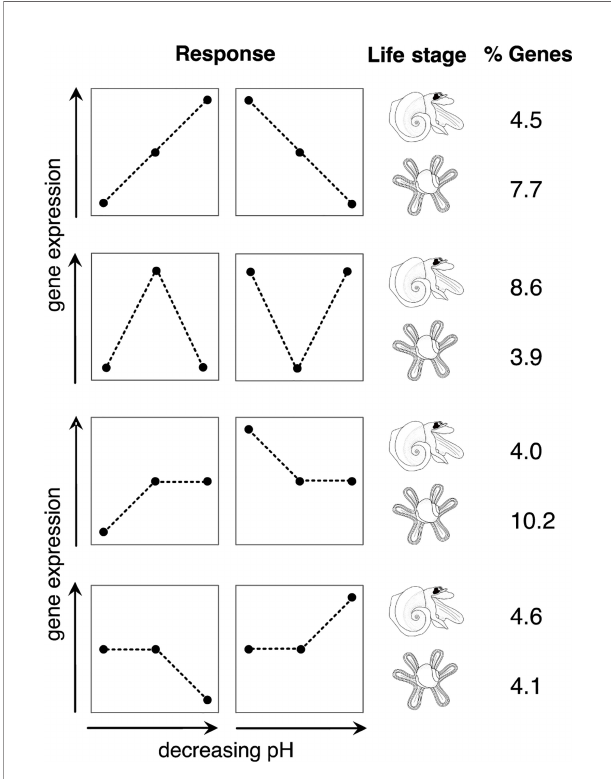
FIGURE 4 | Percentage of genes in adult and juvenile Atlanta ariejansseni following the four main gene expression patterns in response to past, present and future ocean chemistry conditions. Four responses (from top to bottom): gene expression patterns correlated with a decrease in pH (linear response), gene expression patterns in accordance to change of the ambient condition ( ‘ U- shaped ’ response), differential expression patterns only in the past condition and differential expression patterns only in the future condition. The horizontal axis of the response plots represents the direction of decreasing pH from past, present and future ocean chemistry conditions. The proportions (%) refer to the genes in the fi ltered assembly that had a signi fi cant correlation (p-value<0.05) with each of the expression patterns using the Pearson correlation test (see also Supplementary Figures S2 , S3